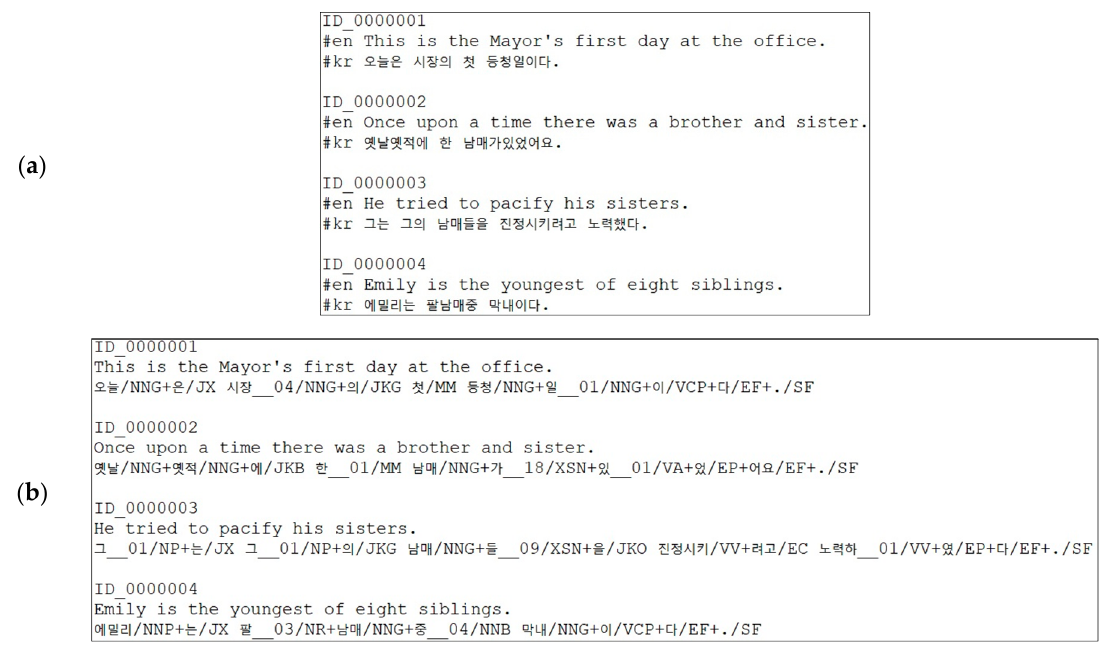
Figure 6. A part of the Korean-English parallel corpus. ( a ) The parallel corpus in its initial form. ( b ) The parallel corpus in the word-sense annotated